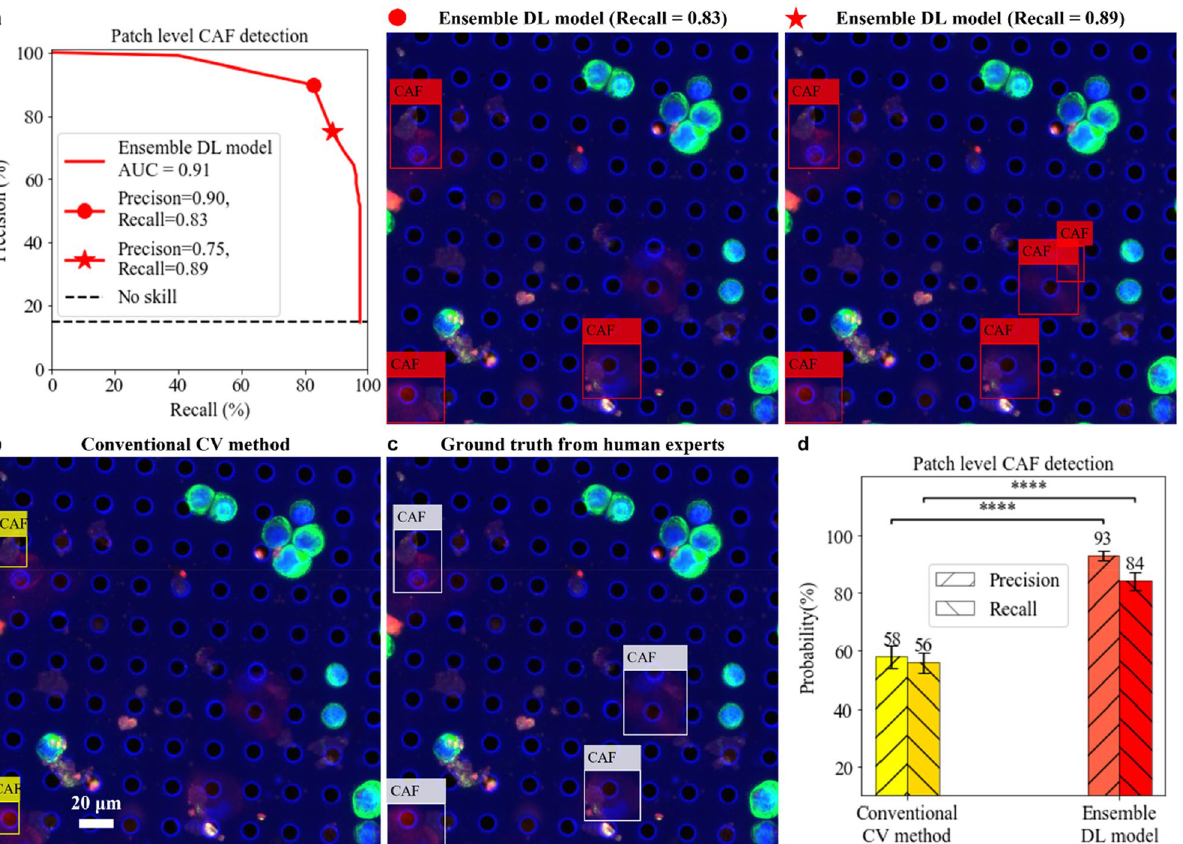
Figure 7. Evaluation of CAF detection. ( a ) Precision-recall curve of the ensemble deep learning (DL) model to detect CAFs in testing patch images. The red dot represents the final chosen operating point. The red star represents another operating point with higher recall but lower precision. Any possible CAF event will be caught but it requires further human analysis to exclude the false alarms. ( b ) CAF detection by conventional computer vision (CV) method. ( c ) Ground truth from human expert annotation. ( d ) Performance comparison between conventional CV method and ensemble DL model to detect CAFs on the patch image level. Both precision and recall of ensemble DL model are significantly higher than the ones of conventional CV method. Statistical analysis uses the ensemble DL model result as the reference to test their difference significance, error bars show standard deviation of precisions and recalls by randomly sampling testing dataset 1000 times and the p -values are specified in the figure for * p < 0.05, ** p < 0.01, *** p < 0.001, **** p < 0.0001, NS not significant, two-sided z